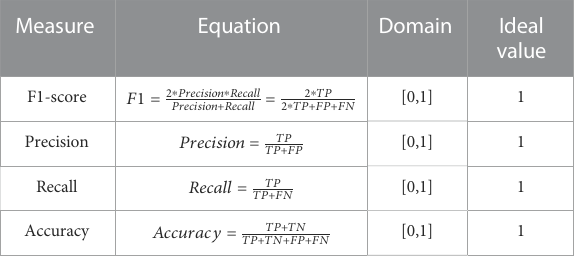
TABLE 2 The performance metrics used in the evaluation.